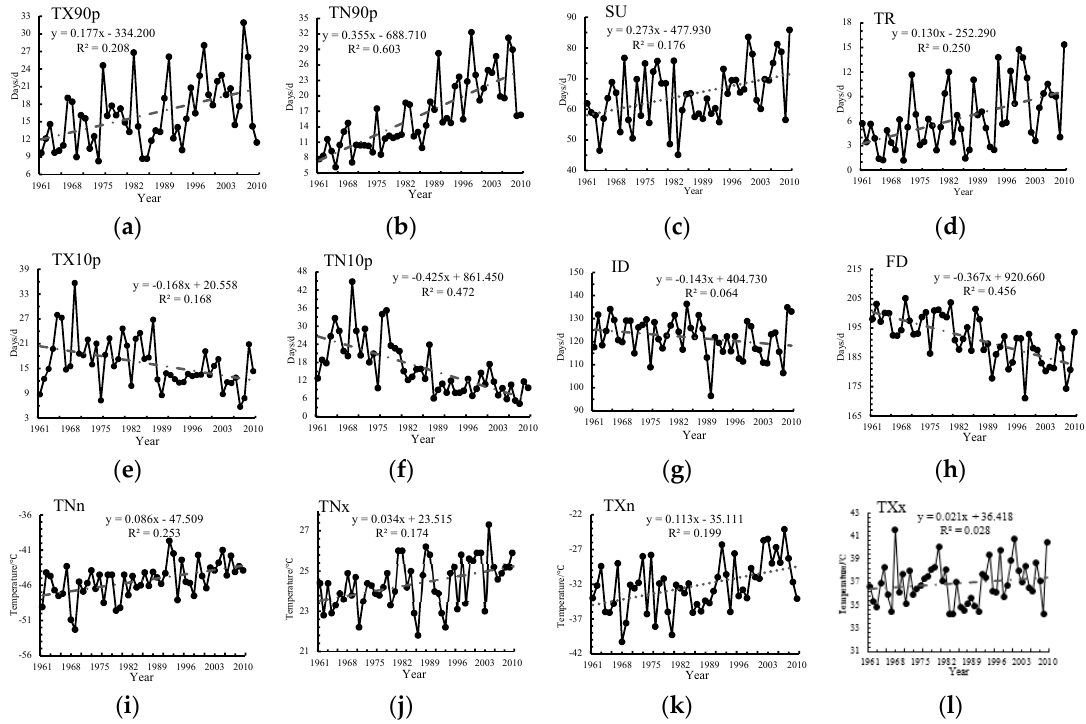
Figure 8. Changing trends in extreme temperature indexes in Heilongjiang Province between 1961 and 2010. ( a ) Warm days; ( b ) Warm nights; ( c ) Summer days; ( d ) Tropical nights; ( e ) Cold days; ( f ) Cold nights; ( g ) Ice days; ( h ) Frost days; ( i ) Minimum value of daily minimum temperature; ( j ) Maximum value of daily minimum temperature; ( k ) Minimum value of daily maximum temperature; ( l ) Maximum value of daily maximum temperature.